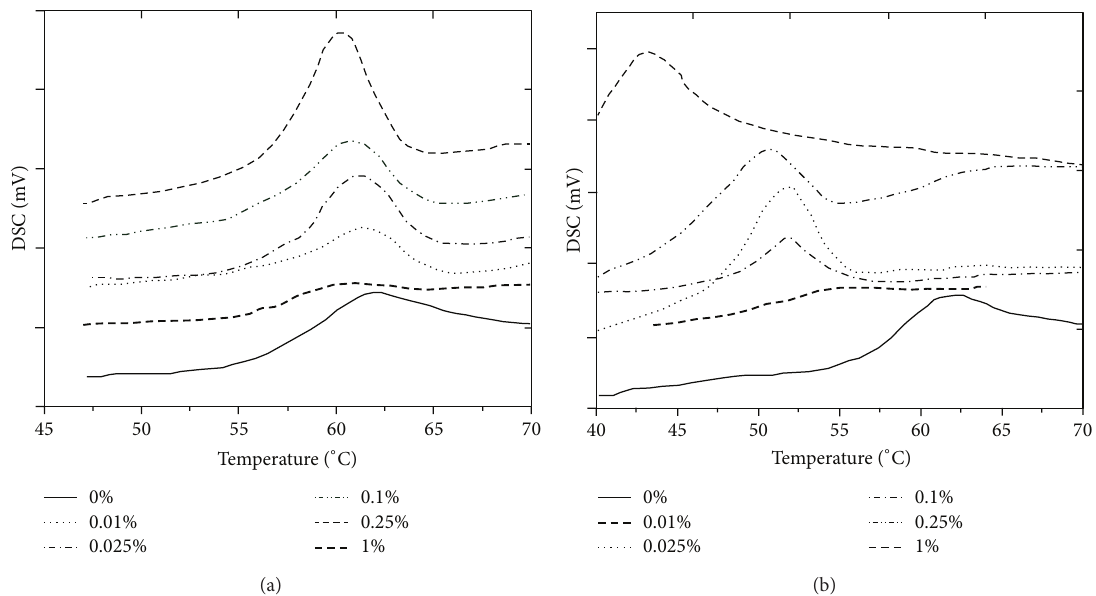
Figure 6: Dynamic DSC thermograms of neat epoxy and its raw MWCNTs nanocomposites (a); neat epoxy and its amino-functionalized MWCNTs nanocomposites (b). After [53].